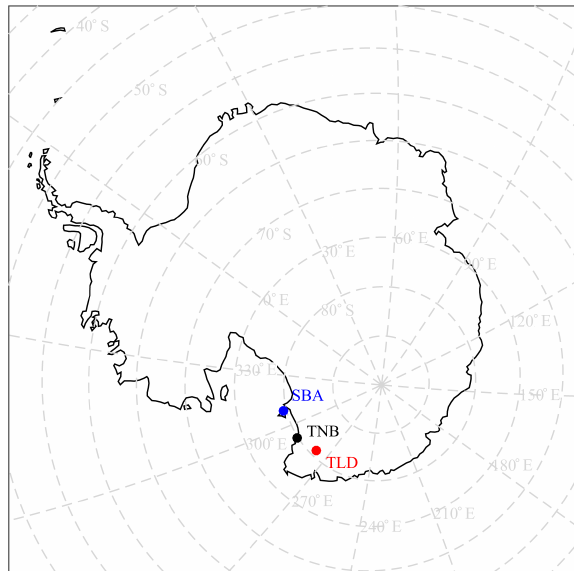
Figure 1. The position of the geomagnetic stations. Dashed lines mark geomagnetic